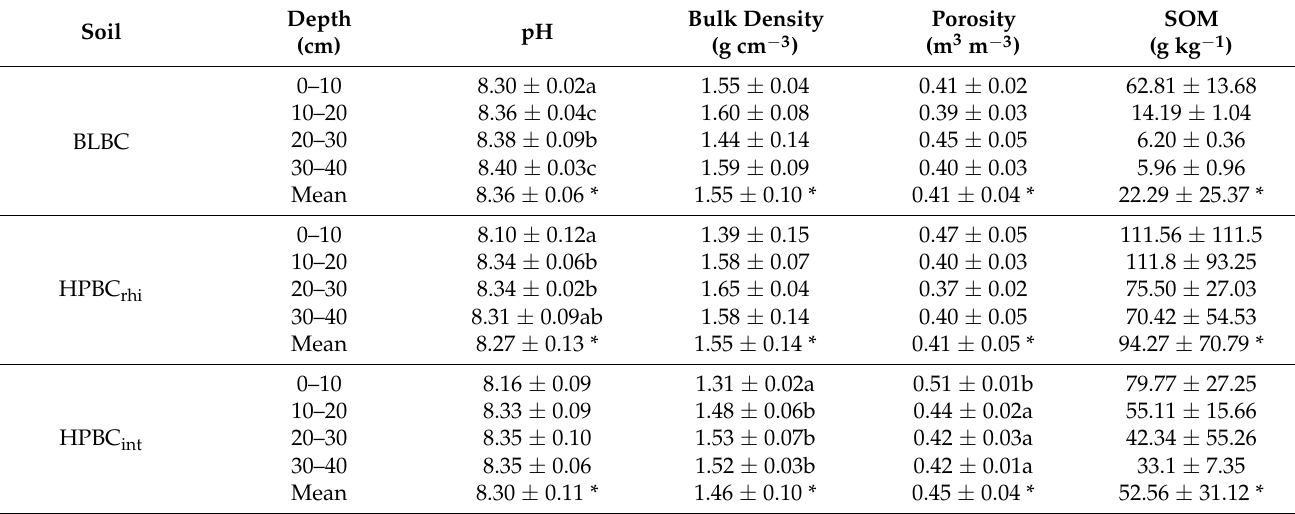
Table 2. Soil pH, bulk density, total porosity, and SOM content in plots BLBC and HPBC.